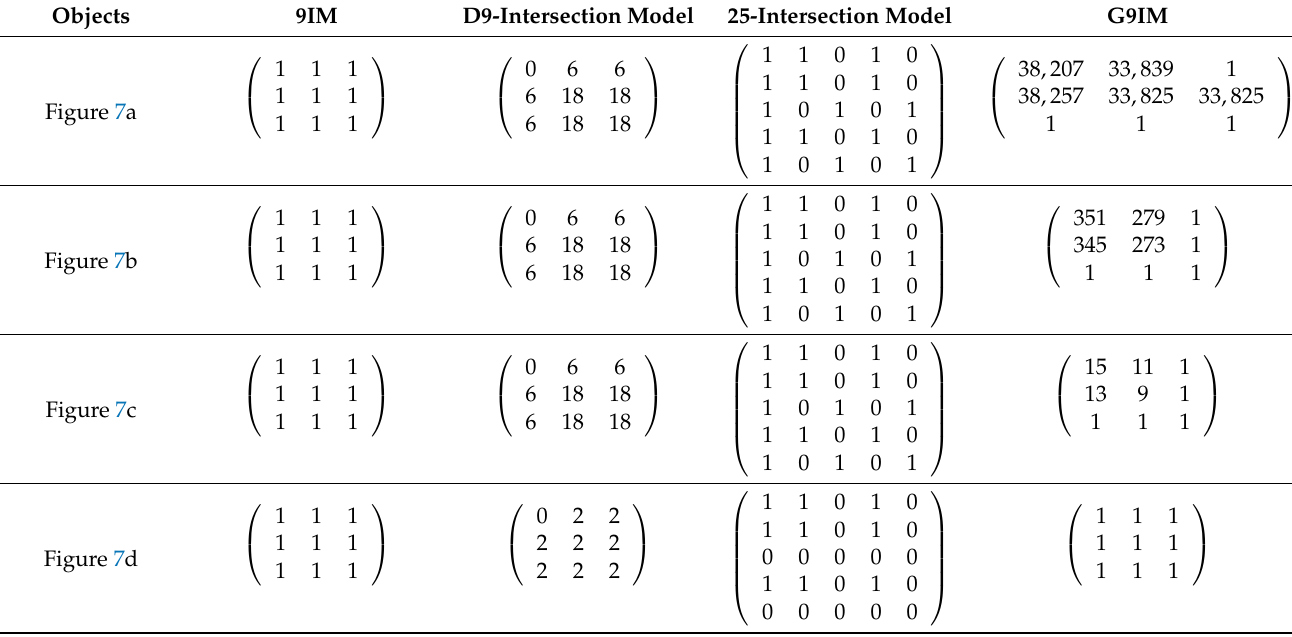
Table 5. The description results of topological relation using four types of models for four types of changes in the water body of Lake Gyaring from 2000 to 2020 in